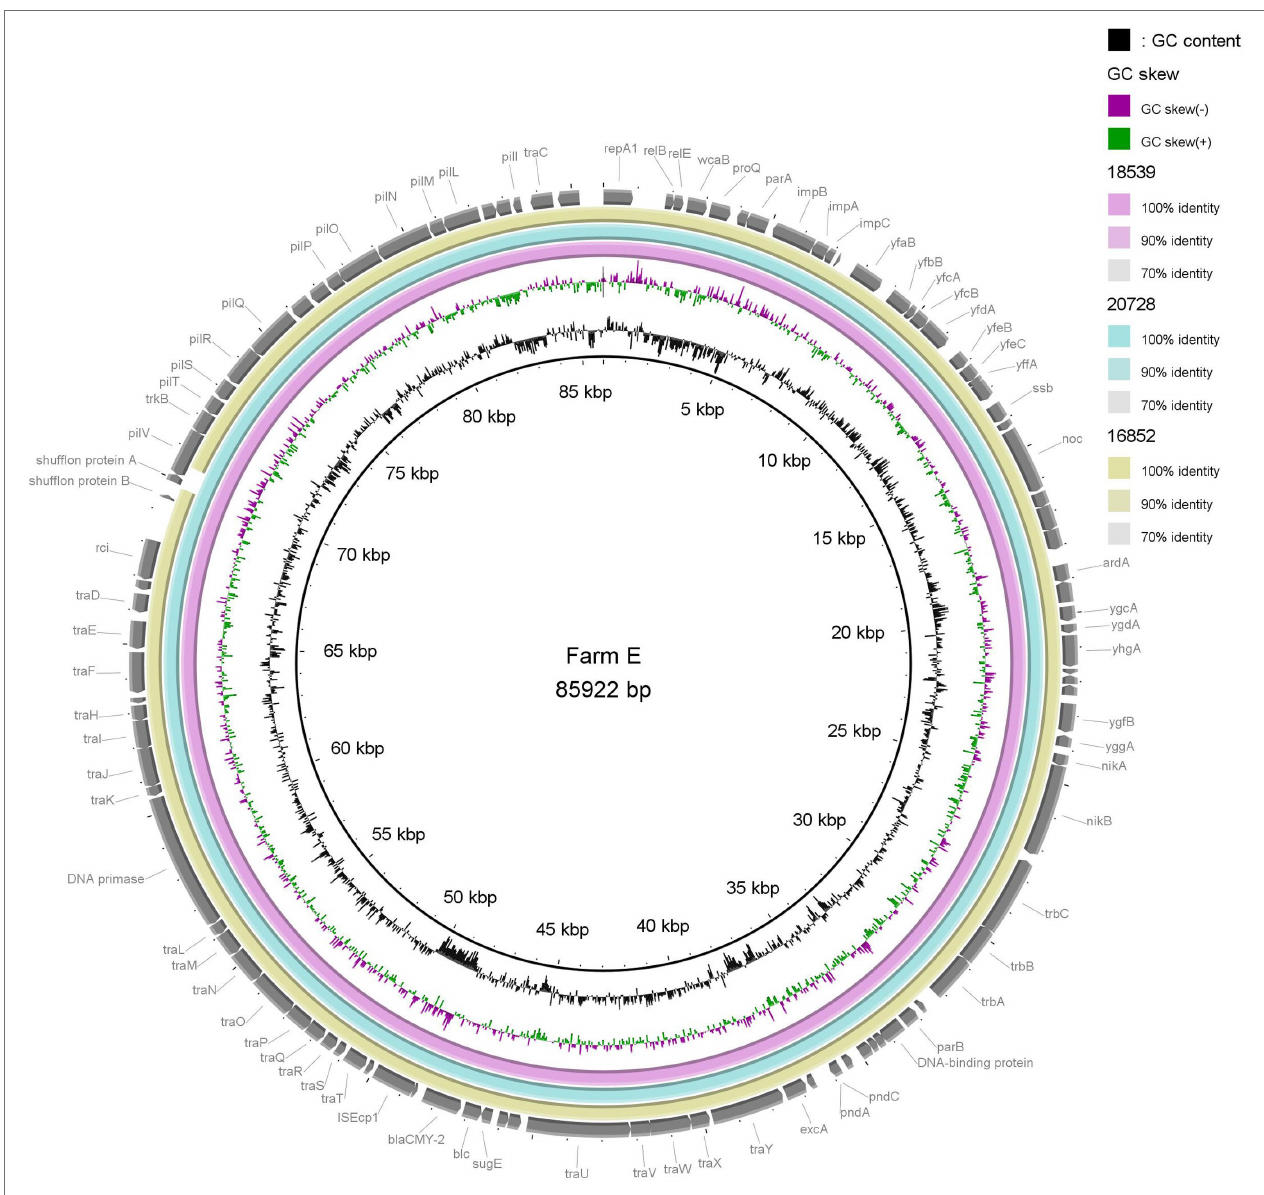
FIGURE 2 | Comparison of three IncK2/ bla CMY-2 plasmids (85–86 kb) originating from extended-spectrum cephalosporin-resistant Escherichia coli of three different sequence types isolated from three different flocks on a single farm. Plasmid p18539 was used as reference.